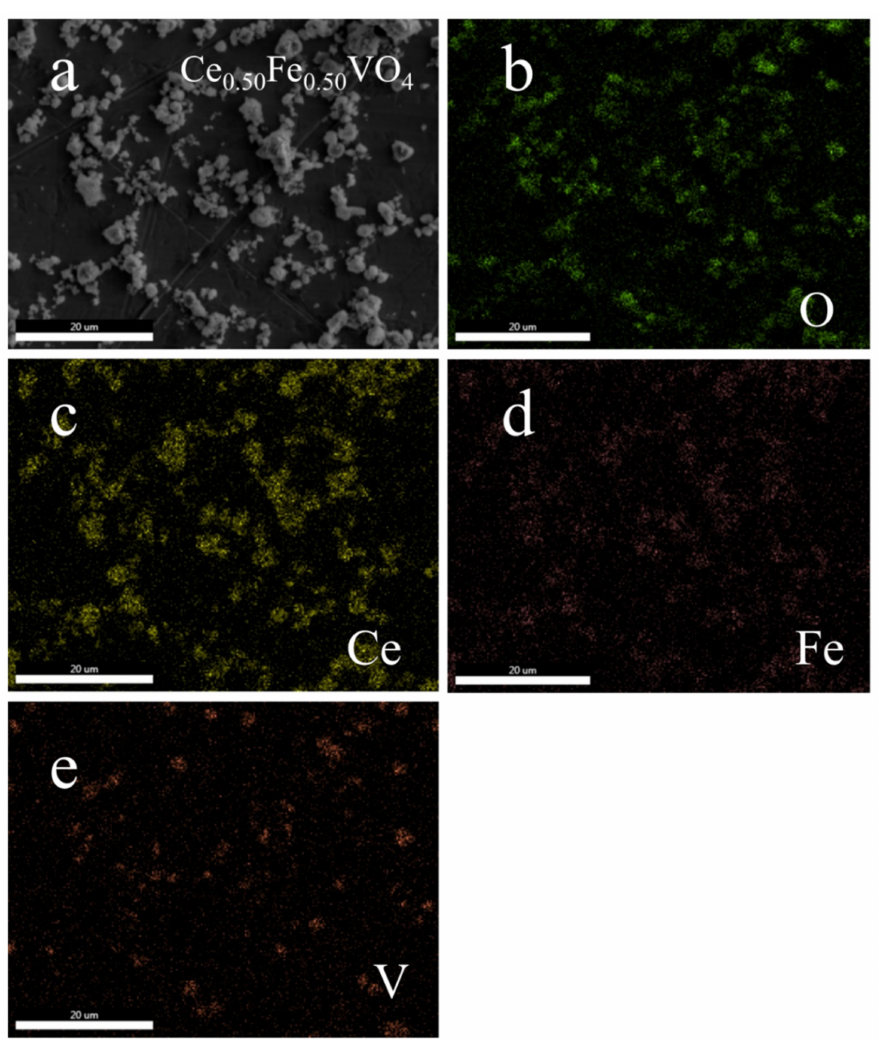
Figure 5. SEM image ( a ) and the corresponding EDX mapping images of O ( b ), Ce ( c ), Fe ( d ) and V ( e ) elements of Ce 0.50 Fe 0.50 VO 4 . The scale bar represents 20 µ